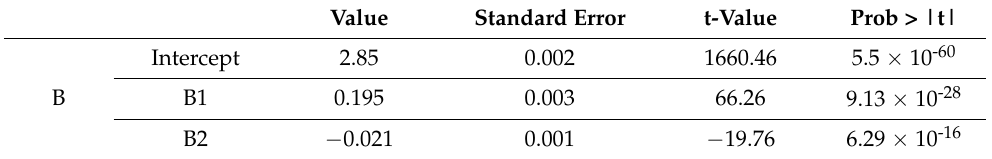
Table 3. Regression analysis of extension vs. resistance of SS conductive yarn.